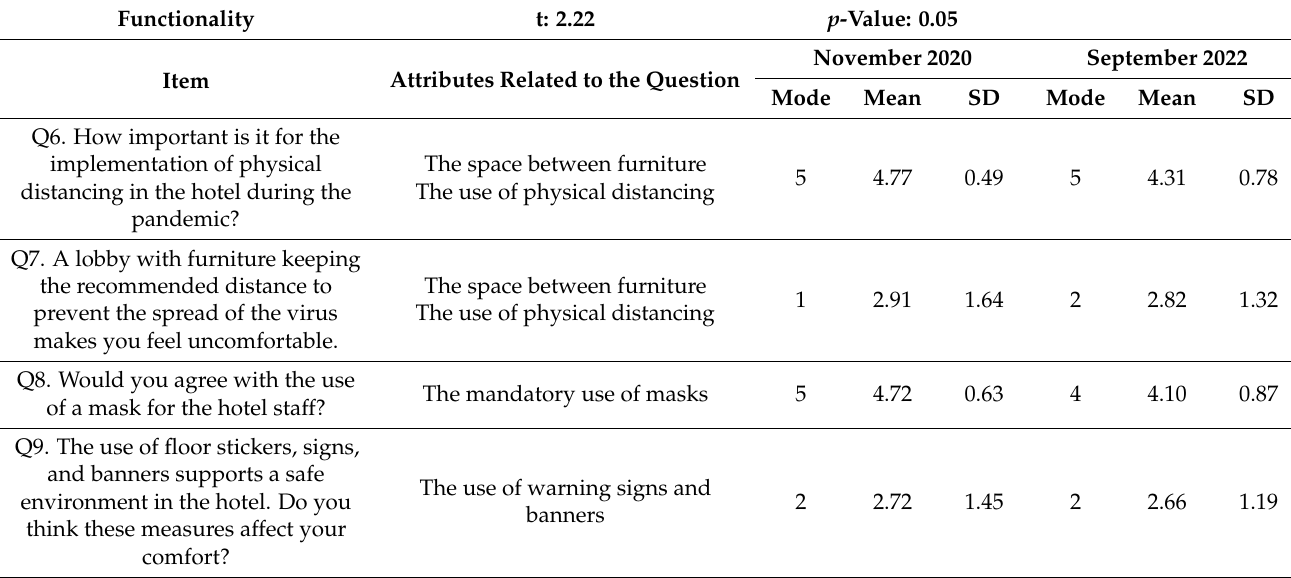
Table 3. Interval data analysis of the Functionality